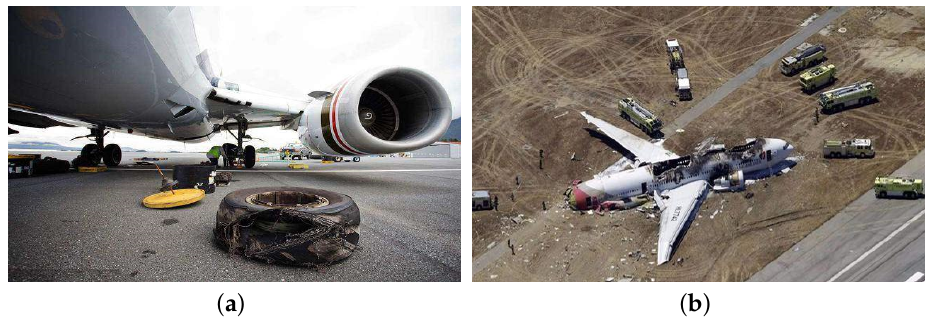
Figure 2. Major accidents due to brake failure. ( a ) A tire blows out during braking. ( b ) An aircraft overruns a runway during